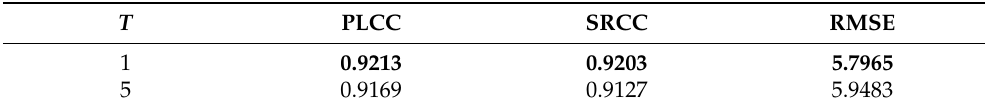
Table 6. Performance results of the proposed method with different error thresholds on the SIQAD database.